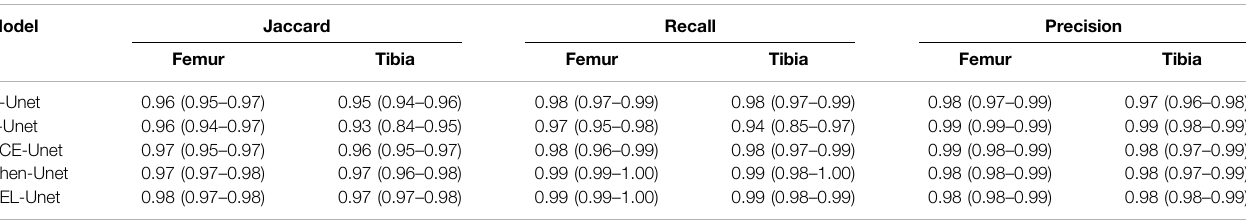
TABLE 5 | Segmentation results as median and inter-quartile range across the fi ve tested models. Model Jaccard Recall Precision Femur Tibia Femur Tibia Femur Tibia D-Unet 0.96 (0.95 – 0.97)